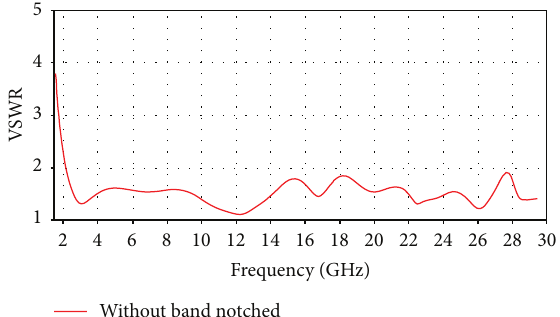
Figure 4: Top and bottom view of the fabricated sample of the proposed